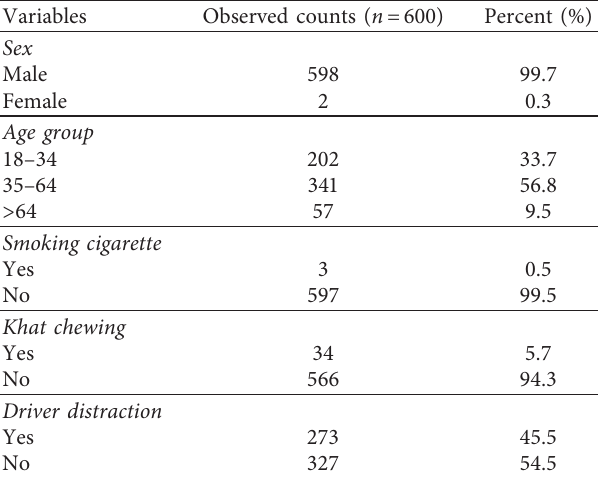
Table 1: Driver-related characteristics of public transport drivers in Addis Ababa, Ethiopia, 2017.